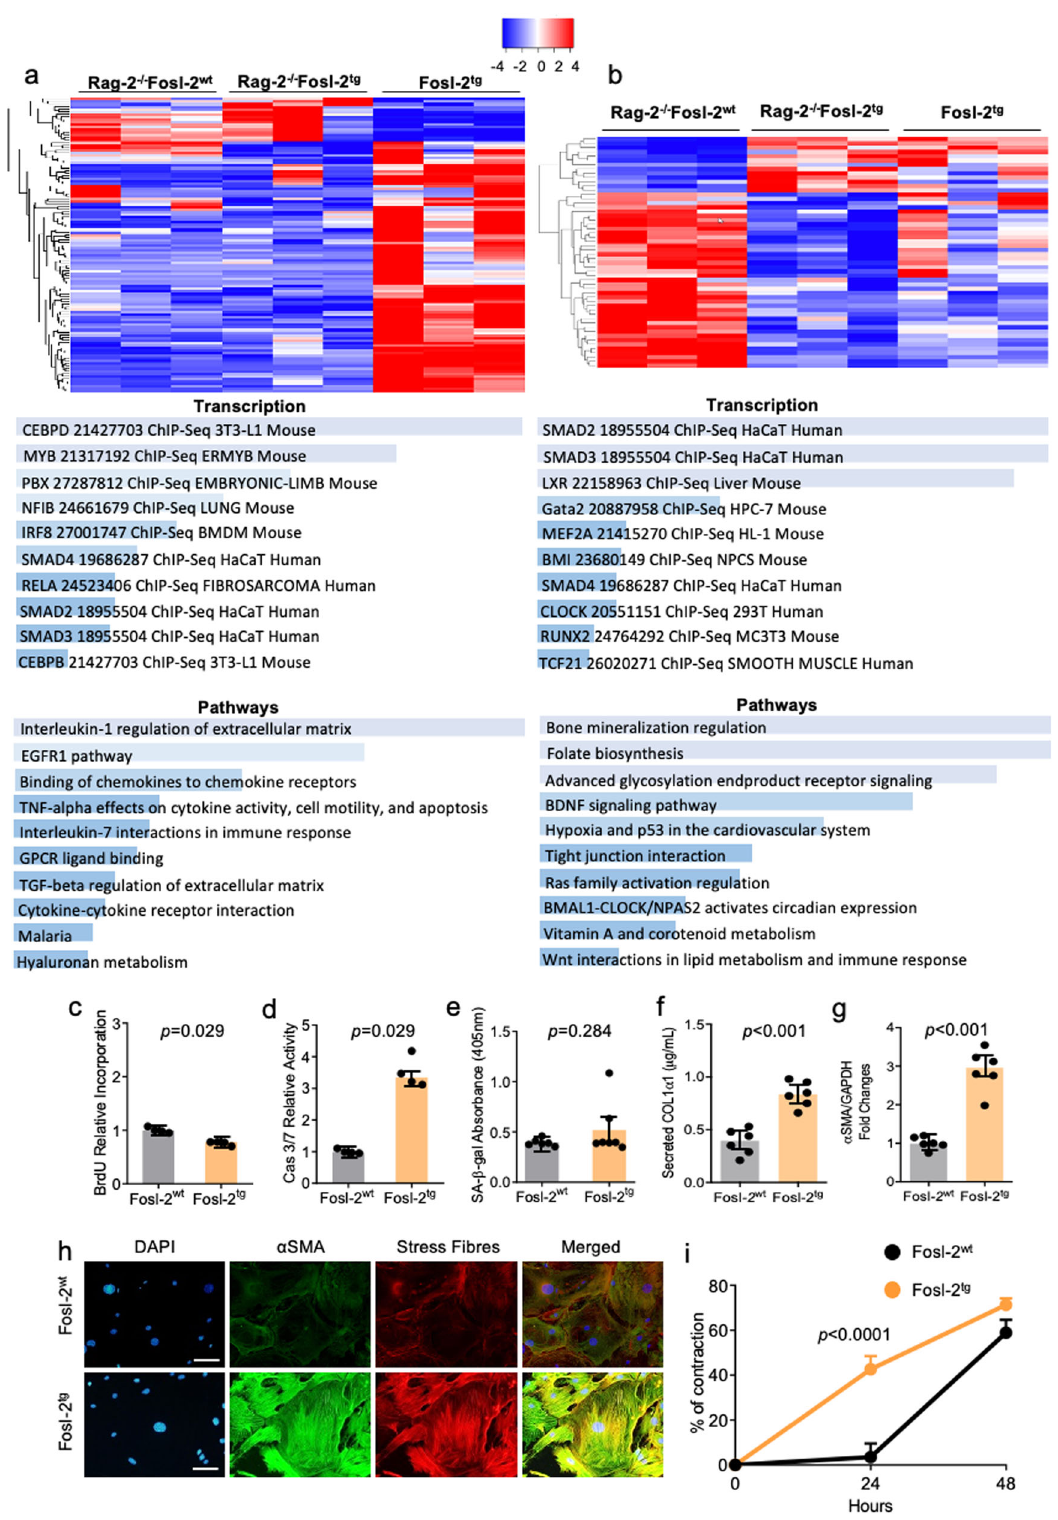
Cell culture . Lin - gp38 + cells were isolated from Fosl-2 wt , Fosl-2 tg , Rag-2 − / − Fosl- 2 wt , and Rag-2 − / − Fosl-2 tg mice. Primary human foetal cardiac fi broblasts were purchased from Cell Applications inc. Both murine and human cells were cultured in DMEM (Gibco) containing 10% foetal bovine serum (FBS), 50U/mL penicillin, 50µg/mL streptomycin (Gibco), and 50mM β -mercaptoethanol (Thermo Fisher Scienti fi c). In selected experiments, cells were stimulated with 10 ng/mL recom- binant TGF- β (Peprotech) and 10 ng/mL LPS (InvivoGen - Labforce AG). Murine Lin - gp38 + cells from passages 2 to 5 and human cardiac fi broblasts from passages 5 to 15 in monolayer culture were used for the experiments.